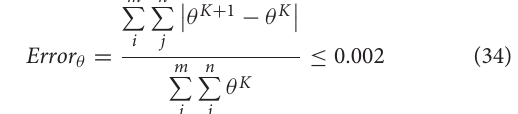
90 ◦ , = 273 ◦ , P com 120 bar, η 0 = = =